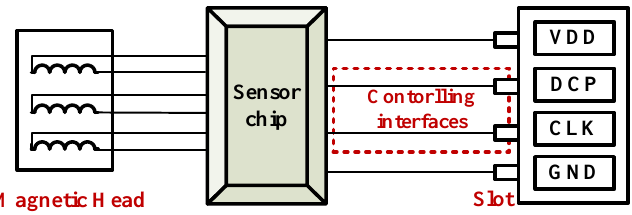
Figure 11. The block diagram of the card swipe